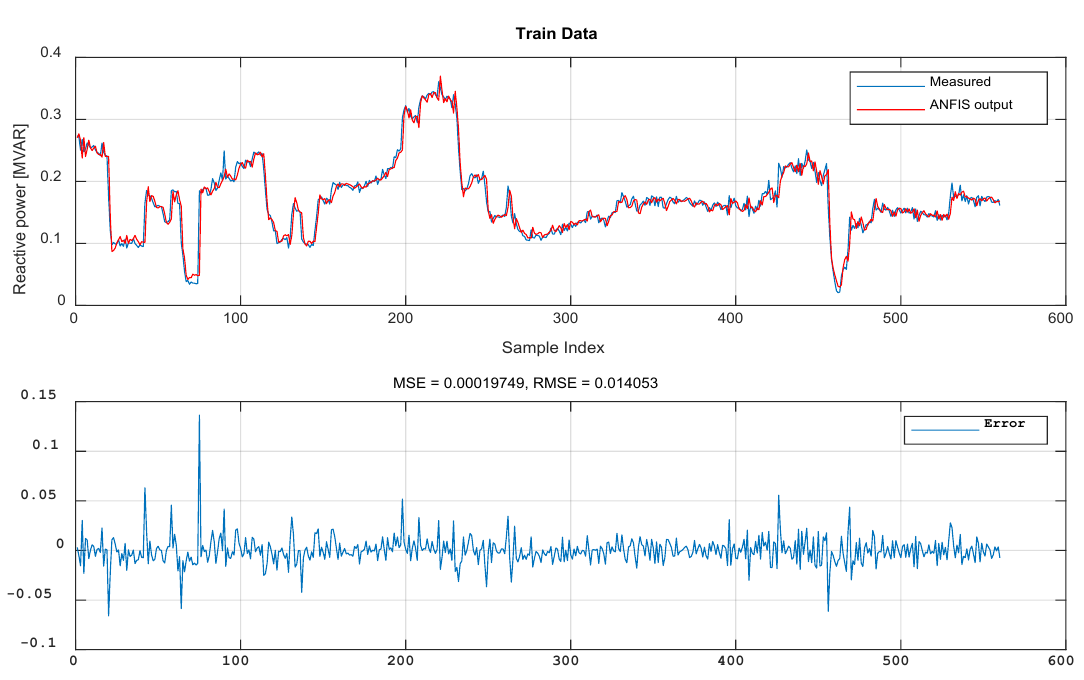
Figure 8. The variation in the measured and predicted reactive power and also of the error for modelling with ANFIS grid partition method for training stage.